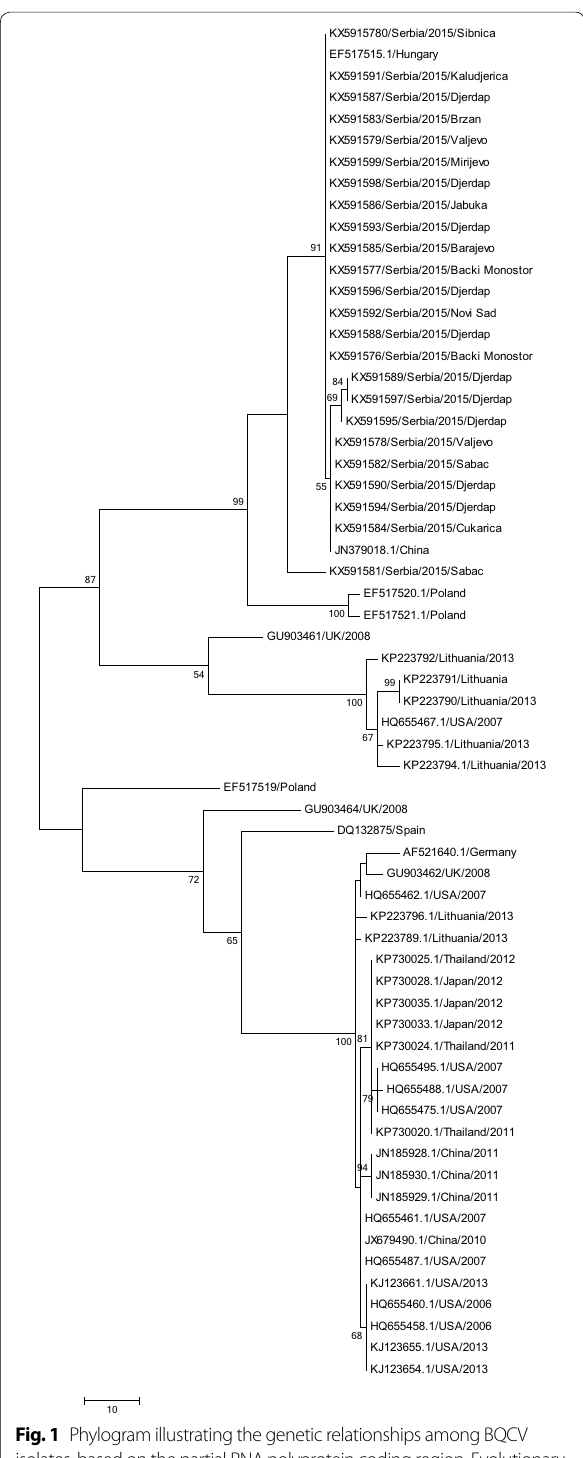
Fig. 1 Phylogram illustrating the genetic relationships among BQCV isolates, based on the partial RNA polyprotein coding region. Evolutionary analyses were conducted in MEGA6 using maximum-parsimony. The analysis involved 63 nucleotide sequences. The percentage of replicate trees in which the associated taxa clustered together in the bootstrap test (1000 replicates) are shown next to the branches; only values > 50% were indicated. Scale bars indicate the numbers of steps for parsimony